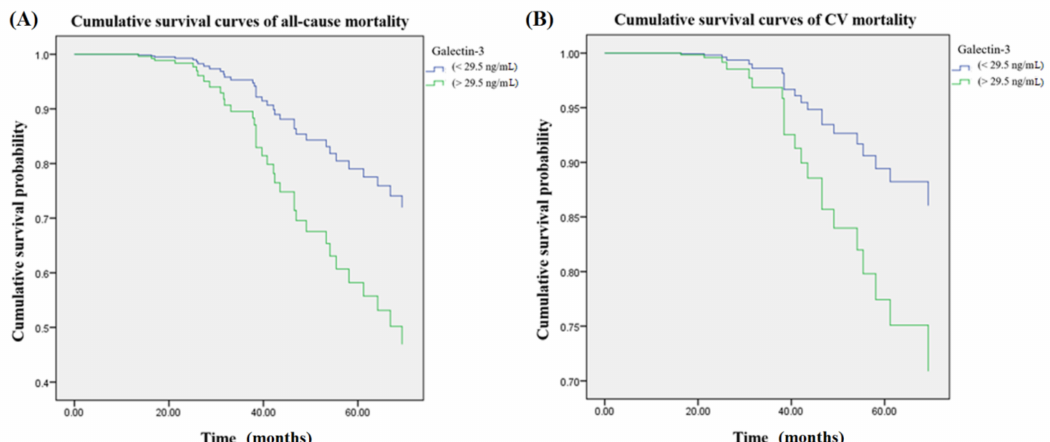
Figure 1. Cumulative survival curves of mortality risks with respect to serum concentrations of galectin-3 after adjusting for galectin-3, VCAM-1, albumin, age, CRP, nPCR, and smoking during follow-up. ( A ) There was an association between higher concentration group of galectin-3 (>29.5 ng/mL) was associated with an incremental risk of all-cause mortality. ( B ) The association between higher galectin-3 concentrations and cardiovascular (CV) mortality was insignificant after multivariable adjustment. VCAM-1 = vascular cell adhesion molecule 1; CRP = C-reactive protein; nPCR = normalized protein catabolic rate.